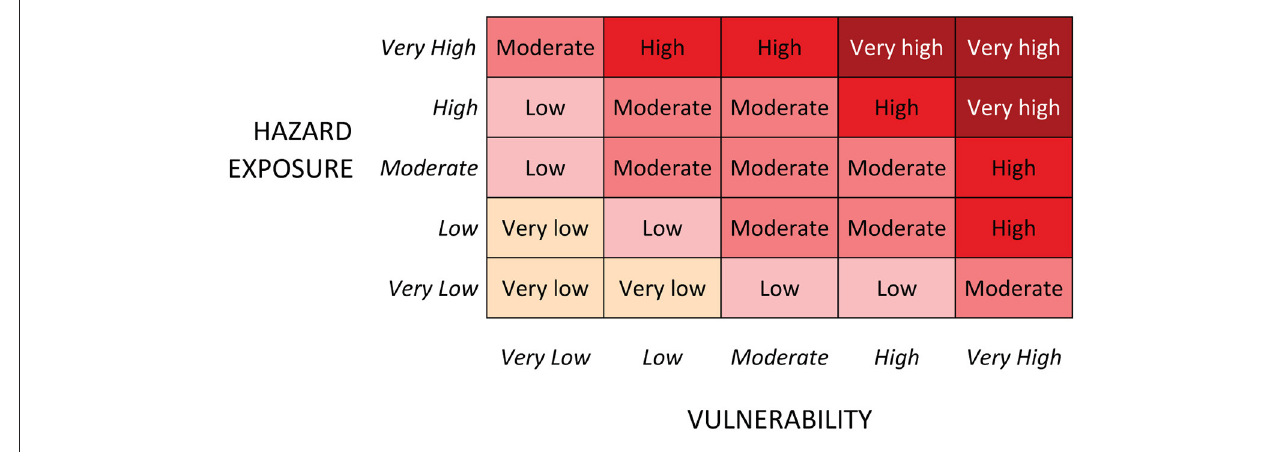
FIGURE 2 | Risk matrix template for the current study.